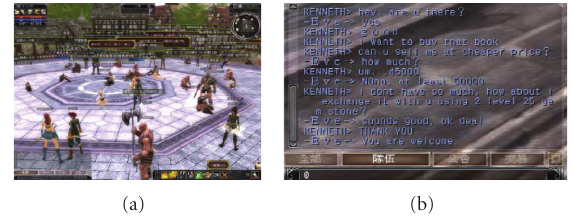
Figure 4: (a) The town centre on a particular day, and (b) some players are willing to talk during